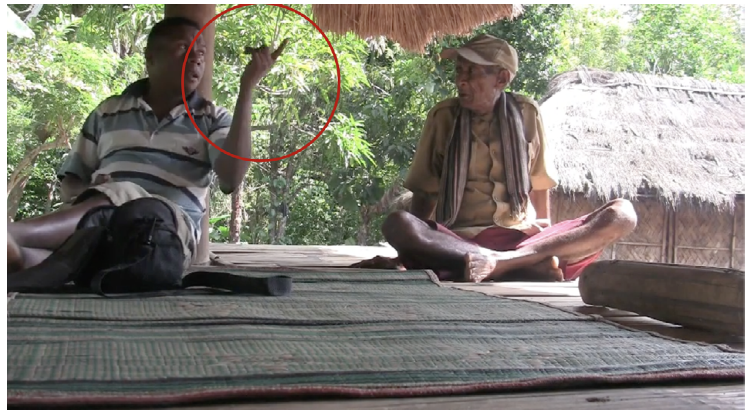
Figure 6. Peny’s first point (line 6)